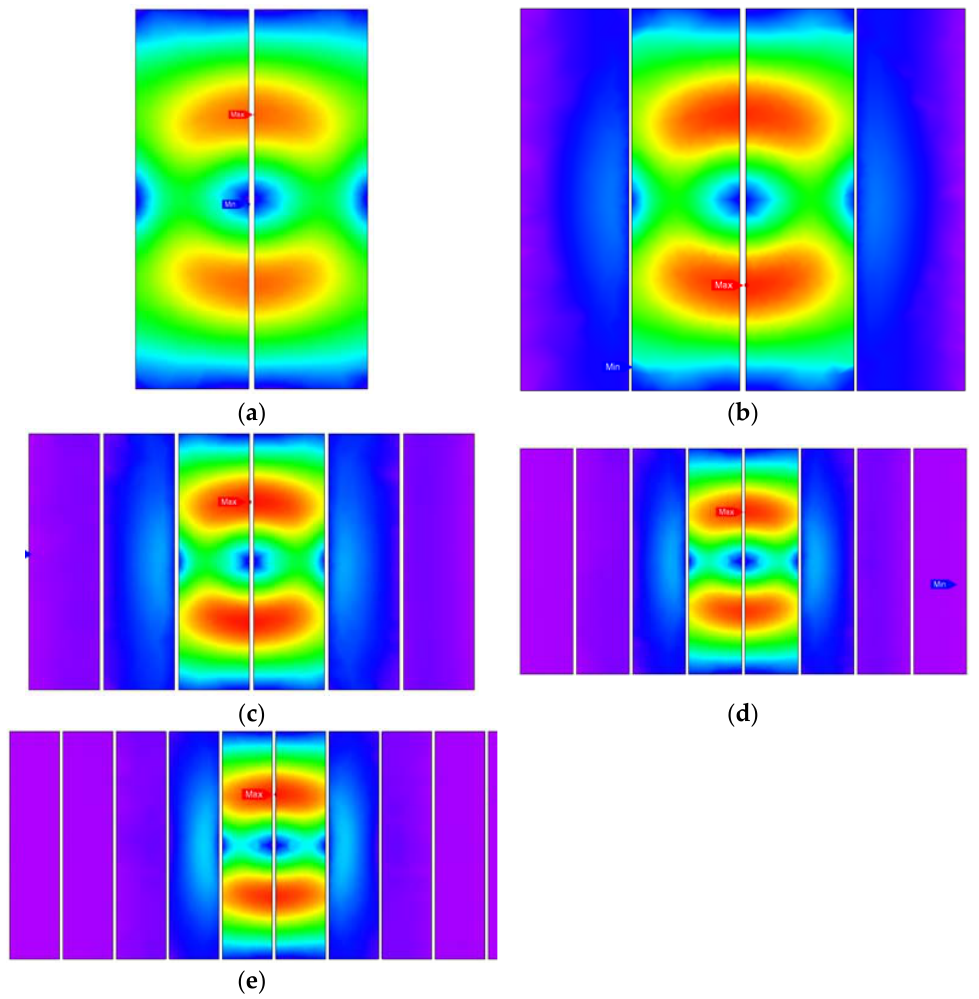
Figure 20. Distributions of the magnet field strength. ( a ) N = 2, ( b ) N = 4, ( c ) N = 6, ( d ) N = 8, ( e ) N = 10.